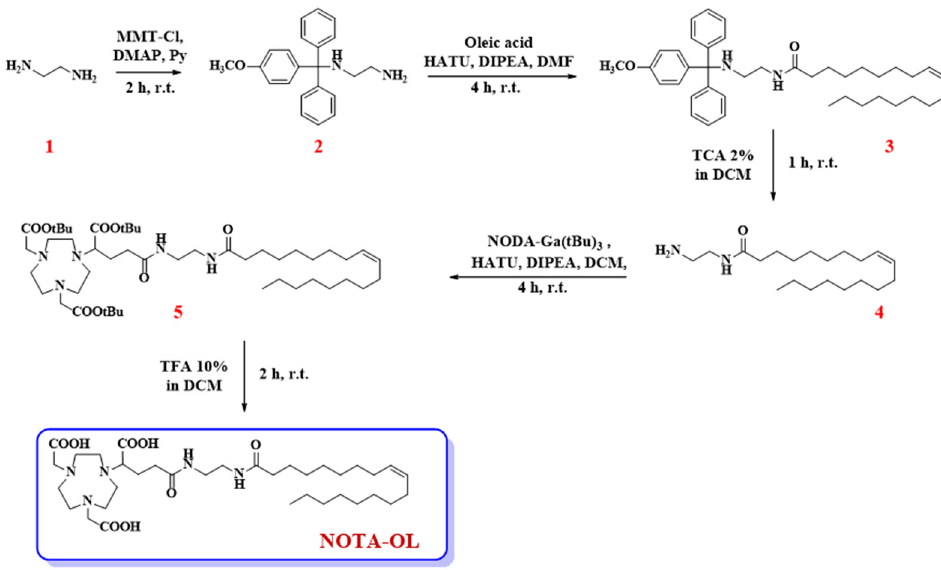
Figure 1. Synthetic procedure for the preparation of the here proposed NOTA-OL derivative.